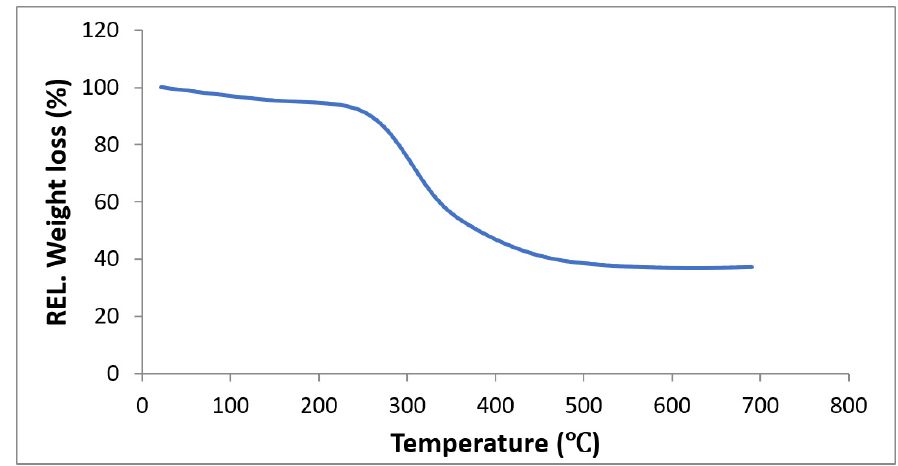
Figure 8. TGA analysis of ABs.